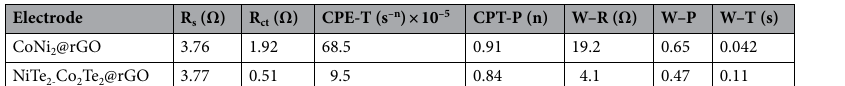
Table 1. The EIS parameters of CoNi 2 @rGO and NiTe 2 -Co 2 Te 2 @rGO.